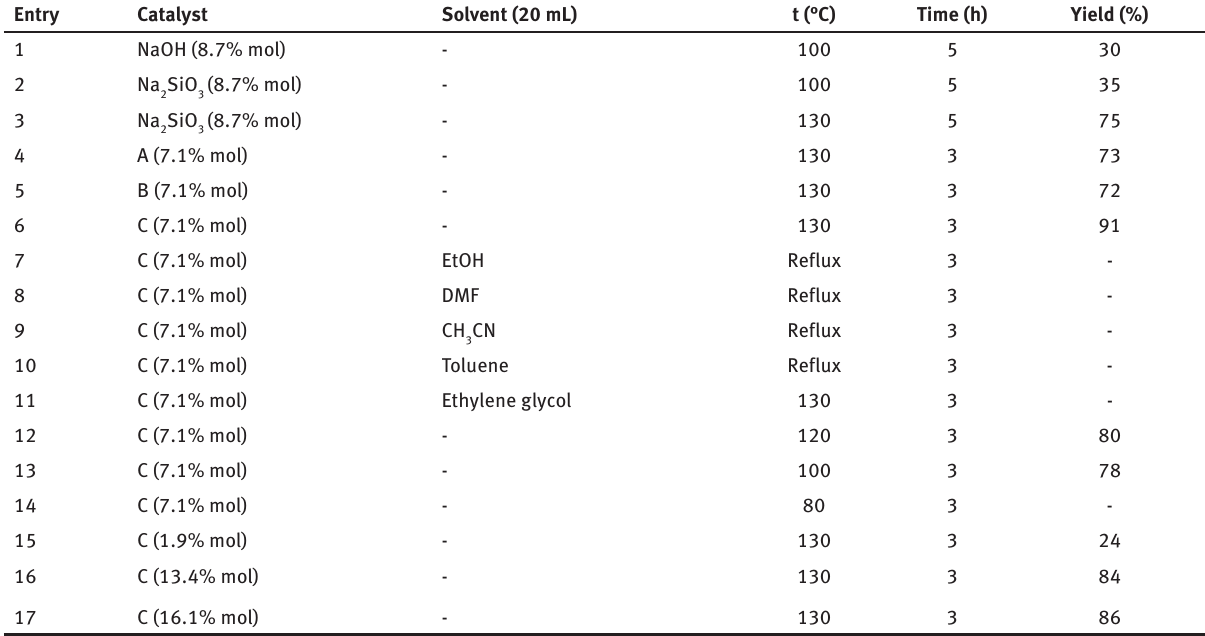
Table 1: Preparation of 1d : catalyst and solvent screening, effect of catalyst dosage and